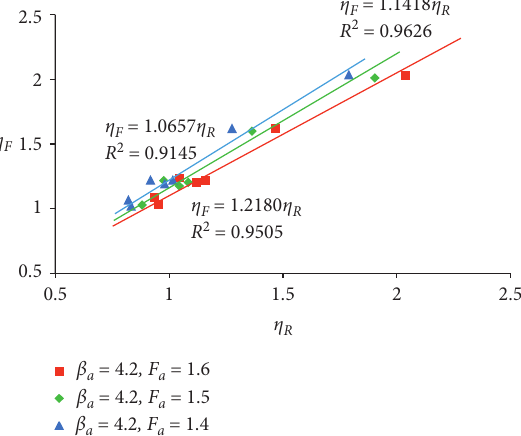
Figure 8: The correlation of η